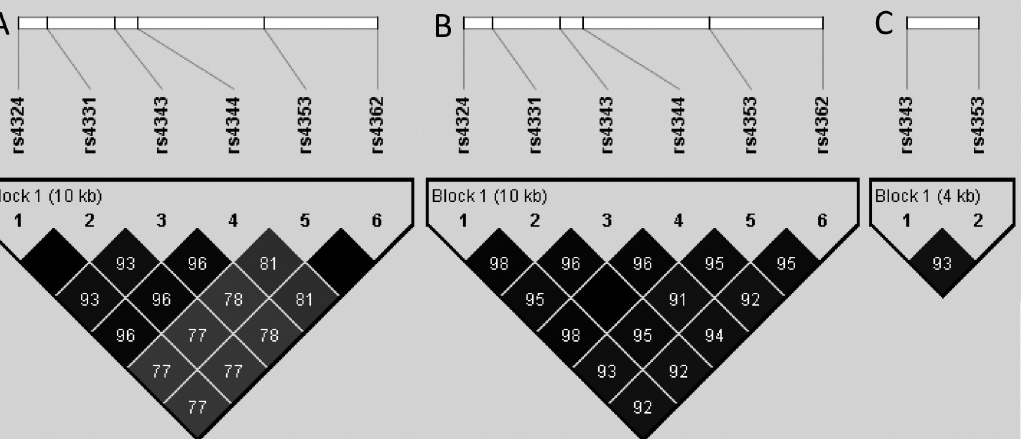
Fig 1. Linkage disequilibrium (LD) relationships between single nucleotide polymorphisms (SNPs) in the genes encoding the angiotensin- converting enzyme (ACE). The top of the figure shows the SNPs. A: HapMap Han Chinese population [15]; B: HapMap European population [15]; C: Echocardiography and Heart Outcome study (ECHOS) population. The strength of LD was determined by R 2 statistics. The decrease in LD in the Han Chinese population probably reflects the previously reported recombinant breakpoint between rs4344 and rs4353 [12]. No such decrease in LD is observed for the HapMap European population and was also not observed in the ECHOS population. The ACE I/D polymorphism was not included in the figure as it has not been genotyped in the HapMap populations [15]. However, this polymorphism is located between rs4331 and rs4343, and is in high LD with these two SNPs [12].